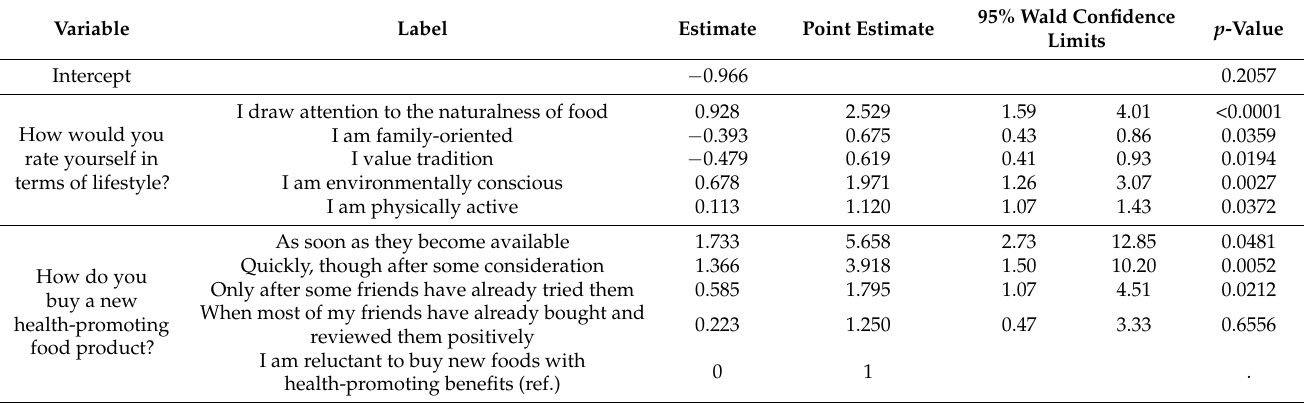
Table 4. Declaration of reading food labels